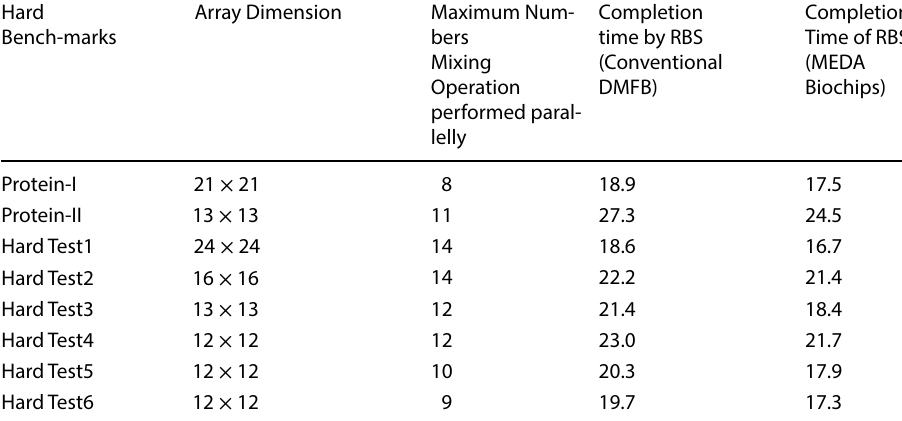
Table 11 Completion period for the benchmarks where ≥ 8 numbers of mixing operation performed simultaneously on both traditional and MEDA biochips